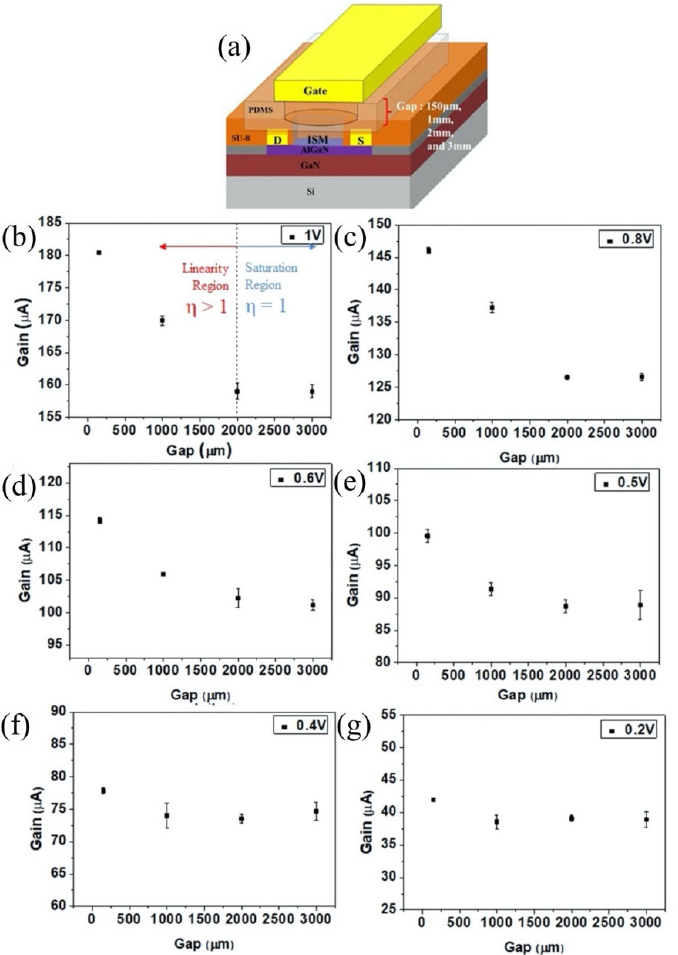
Figure 10. ( a ) Test setup to determine the effect of gate terminal distance and applied gate potential on sensor response ( b – g ) relationship of AlGaN/GaN HEMT current gain with different gate terminal distances and applied gate potential. Reprint with permission from reference [201]. Copyright 2018 Springer